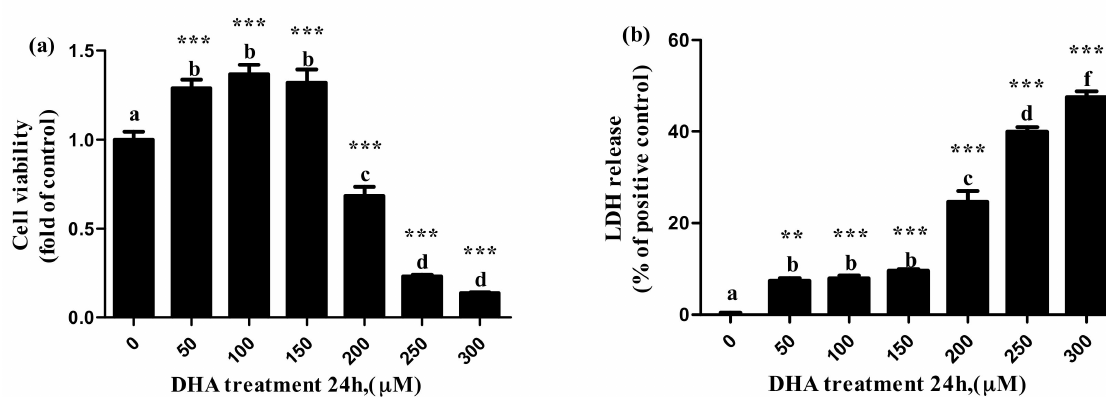
Figure 1. The effect of different concentrations of DHA-treated BRL-3A for 24 h on the cell viability ( a ) and lactate dehydrogenase release ( b ) ( n = 5). Values are means with SEM, the SEM was presented with vertical bars; means with different letters are significantly different from one another ( p < 0.05) as determined by variance analysis followed by multiple comparisons with LSD post-hoc test; ** statistically significant differences vs. control ( p < 0.01); *** statistically significant differences vs. control ( p < 0.001).